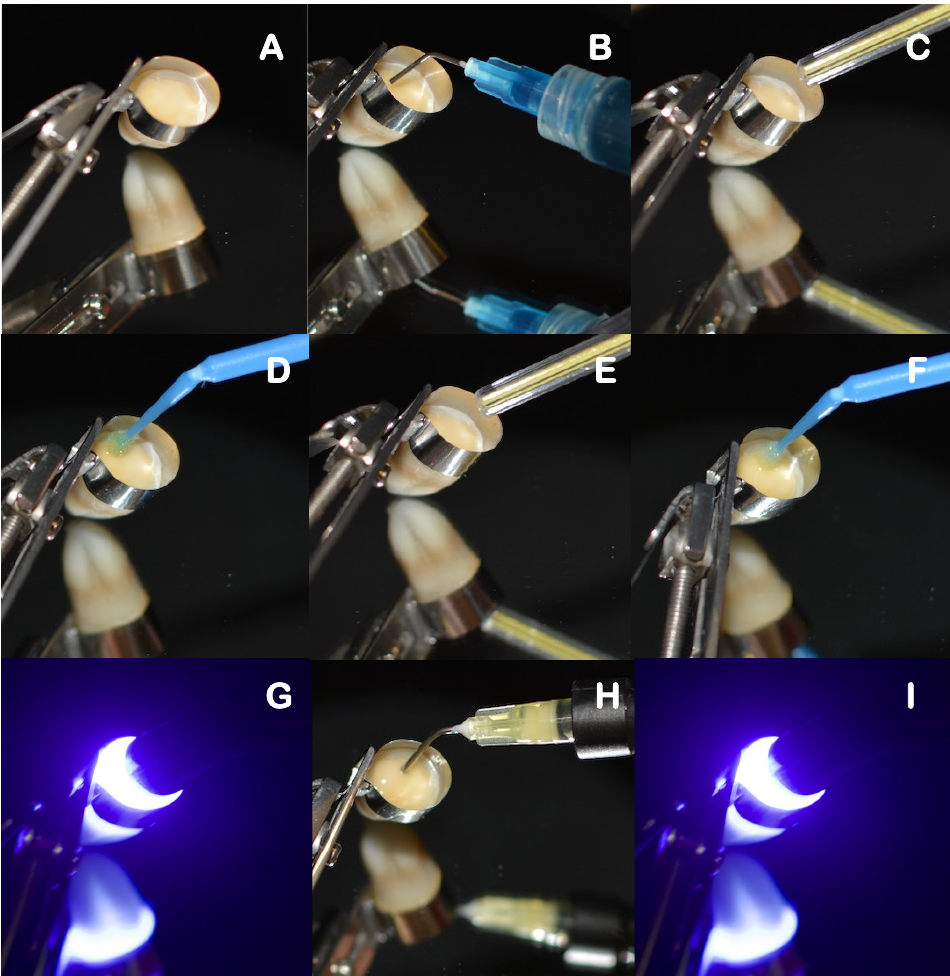
Figure 5. Restorative procedure of the Optibond FL (full etch-and-rinse) group, where: ( A ) is the application of the restorative matrix band, ( B ) etching protocol, ( C ) rinsing and drying step, ( D ) application of the primer (part I), ( E ) drying step, ( F ) application of the bond (part II), ( G ) light curing of the adhesive, ( H ) application of the flowable self-adhesive composite, and ( I ) light curing of each increment.